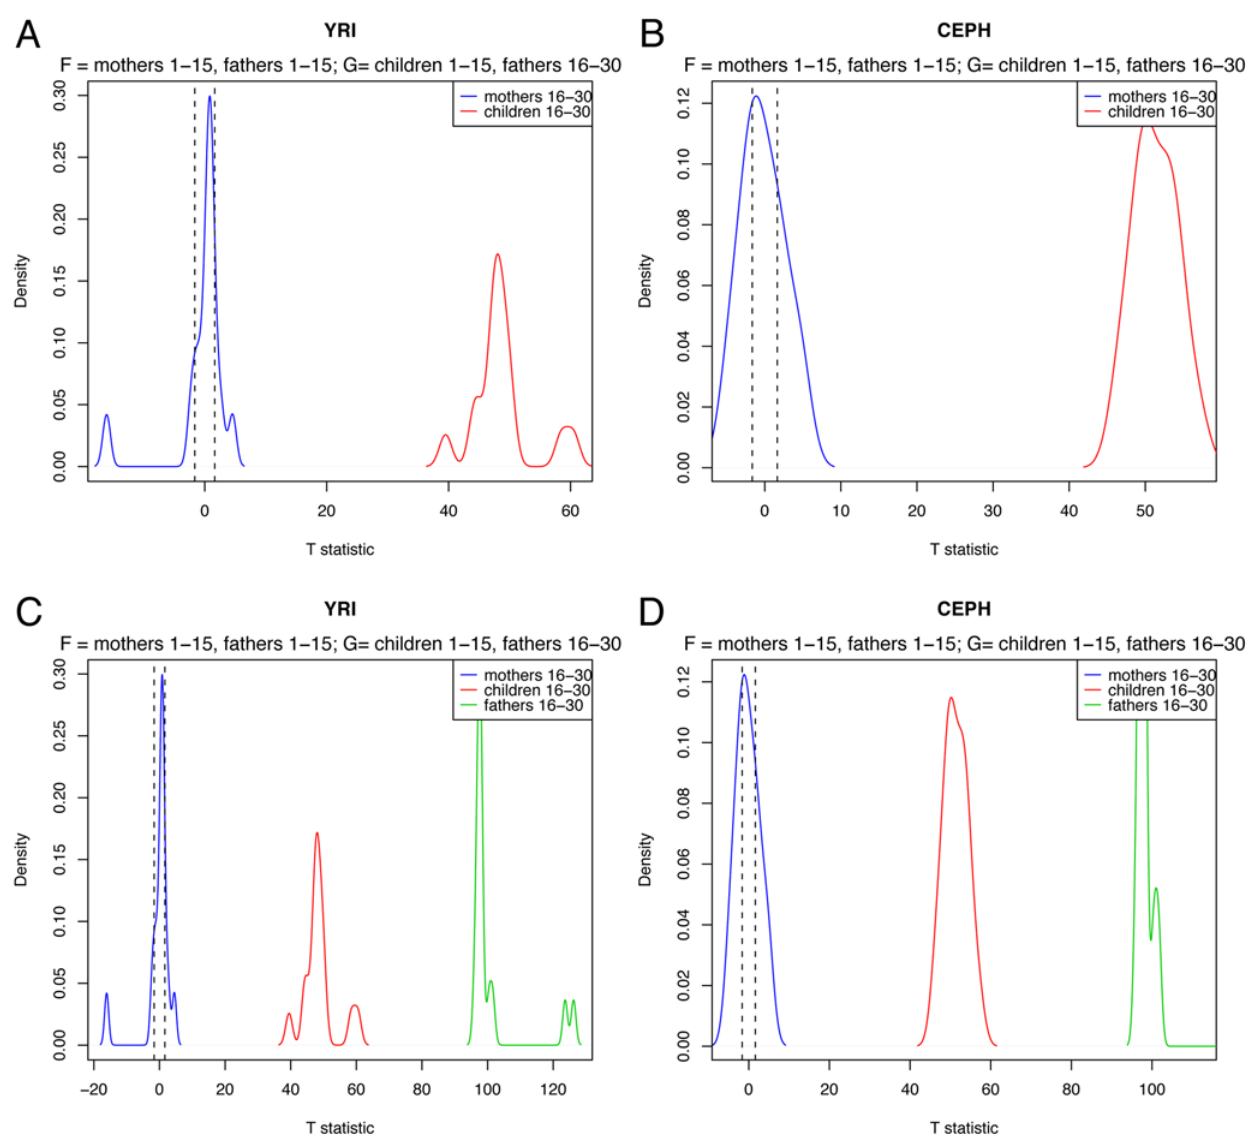
Figure 2. Distribution of T . Distributions of T for out-of-group samples who are related (red line) and unrelated (blue line) to individuals in G for HapMap YRI (A) and HapMap CEPH (B) populations. (C) and (D) show the same distributions as (A) and (B) respectively, with the addition (green line) of individuals who are in G and unrelated to F (i.e., true positives). Dashed black lines indicate the T significance thresholds of 6 1.64 at nominal a ~ 0 : 05